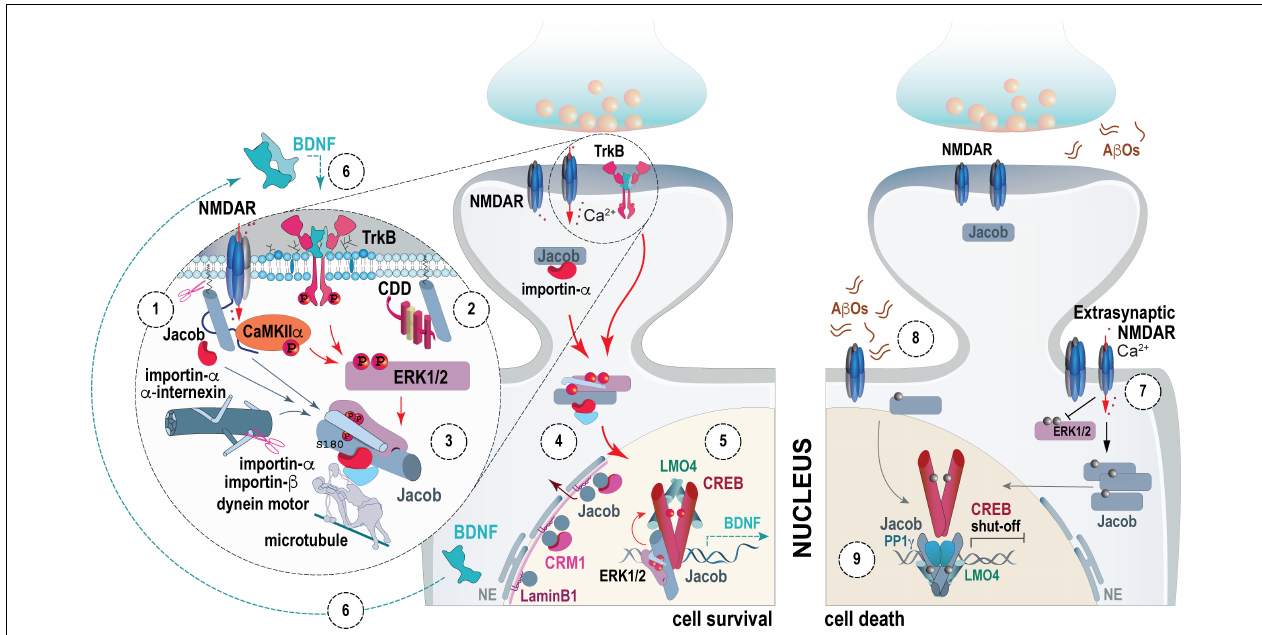
FIGURE 1 | Molecular mechanisms underlying synapse-to-nucleus trafficking of Jacob and its nuclear function. N-terminal myristoylation is a prerequisite for the extranuclear localization of Jacob. In synapses, Jacob associates with the GluN2B-containing NMDA receptor complex as well as CaMKII- α (1). The synaptic localization is regulated by the neuronal Ca 2 + sensor protein Caldendrin (2) that competes with importins for Jacob binding. NMDAR activation leads to calpain-mediated cleavage of the myristoylated part of the protein and releases Jacob from the plasma membrane. Concomitantly, synaptic GluN2B-containing NMDAR activity leads to CaMKII- α dependent activation of ERK1/2, subsequent phosphorylation of Jacob at S180 and formation of a stable trimeric complex between phosphorylated Jacob, active ERK1/2 and the proteolytically cleaved fragment of the neuronal filament α -internexin (3) which protects pJacob and pERK1/2 against phosphatase activity during retrograde transport to the nucleus but likely also in the nucleus. Long-distance transport of the Jacob signalosome involves its association with importin- α , importin- β , and, subsequently the molecular motor dynein that moves along microtubules in a retrograde direction. GluN2B-containing NMDA receptor activity mediates the association of Jacob with the inner nuclear membrane where it transiently binds to LaminB1 (4). The association with the canonical CRM1-RanGTP-dependent export complex defines its nuclear residing time. In the nucleus, the Jacob signalosome associates with the CREB complex and results in its sustained activation by docking the active ERK1/2 in its close vicinity (5). This, in turn, promotes CREB-dependent gene expression of plasticity-related genes like Bdnf . In early development, BDNF induces the nuclear accumulation of phosphorylated Jacob in an